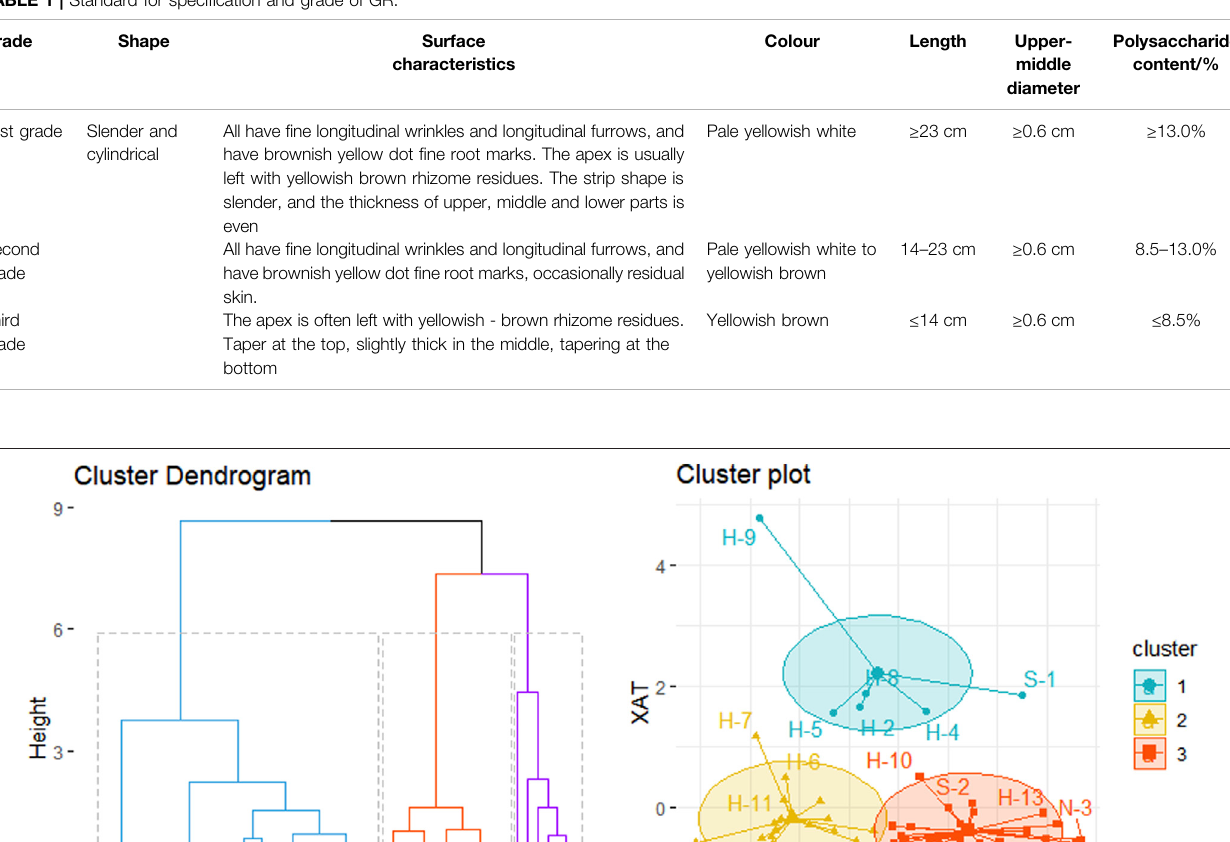
TABLE 1 | Standard for speci fi cation and grade of GR.